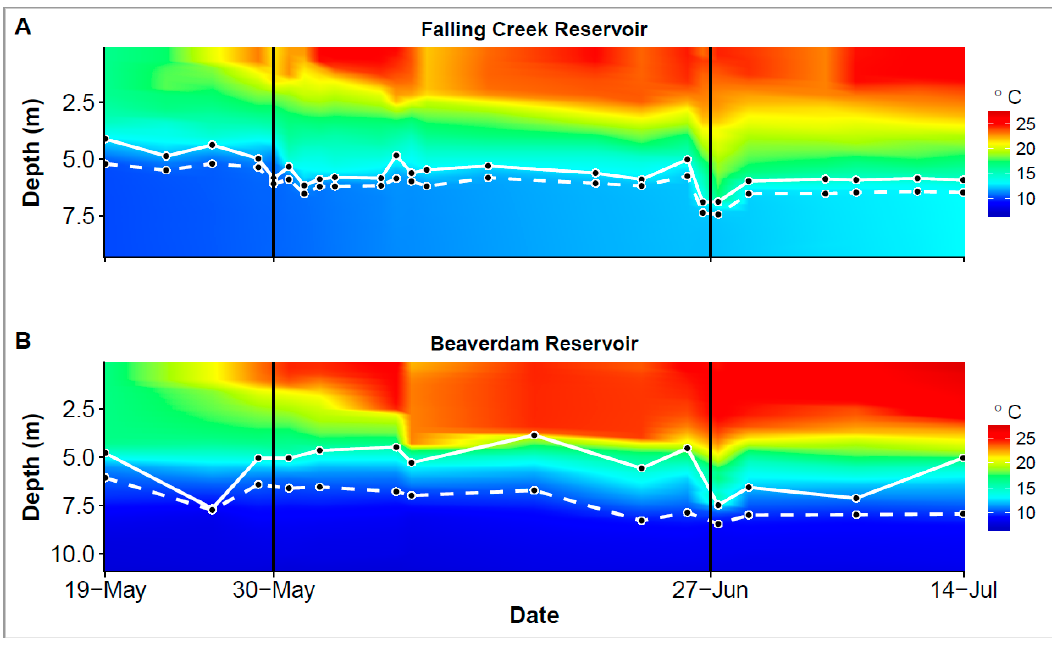
Figure 2. Water column temperature of ( A ) FCR and ( B ) BVR during summer 2016. The solid white line is the parent thermocline depth and the dashed white line is the lower metalimnetic boundary. Sampling dates are denoted by black points and the values in between these points are interpolated. The two mixing events in FCR (EM1 and EM2) are denoted by vertical black lines.